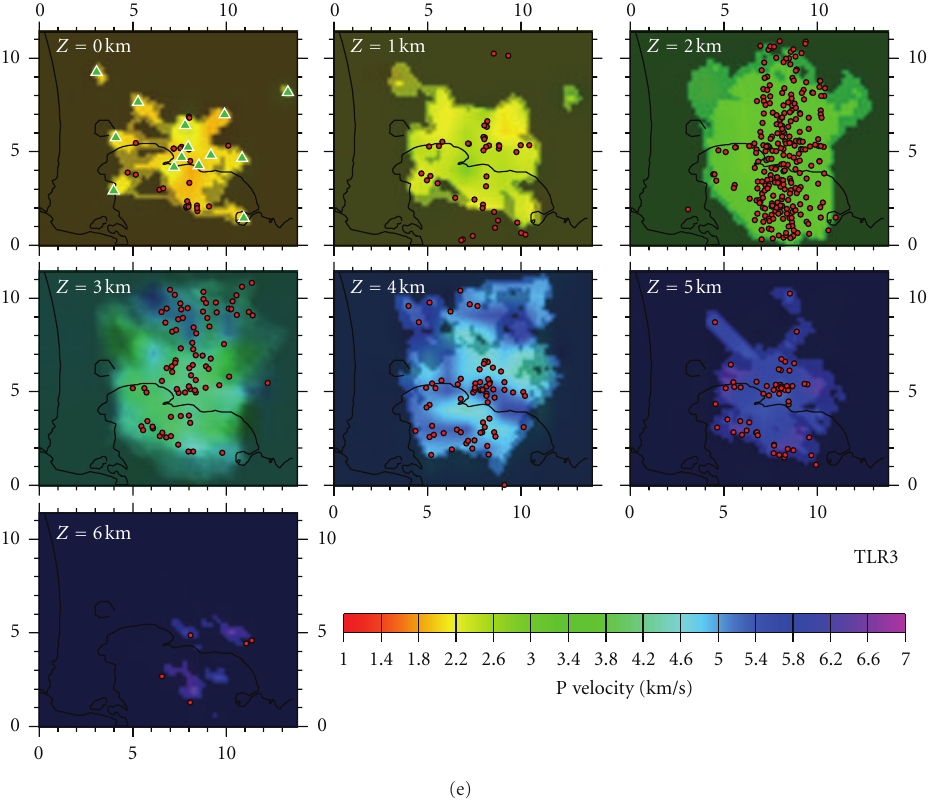
Figure 17: V P fields obtained by the di ff erent methods along horizontal planes at depths Z = 0,1,2,3,4,5,6 km. Other details as in Figure 16.